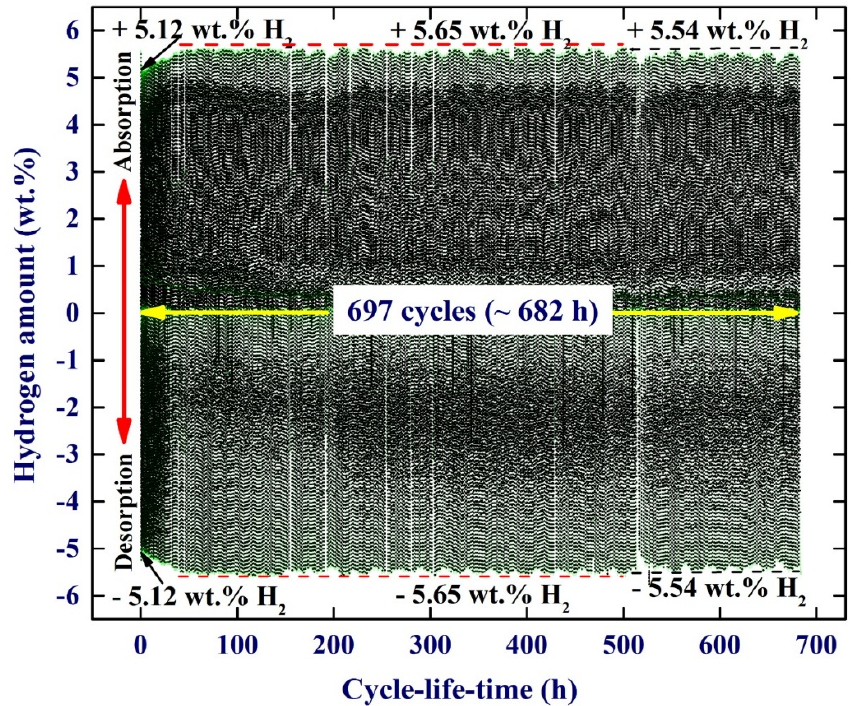
Figure 10. ( a ) Hydrogenation and consequent dehydrogenation curves of 697 complete cycles performed within 682 h for nanocomposite MgH 2 /5.2TiC/4.6FeCr powders obtained after 50 h of ball milling. The hydrogen absorption and desorption processes were achieved at a constant temperature of 275 ˝ C with an applied pressure of 100 mbar/8